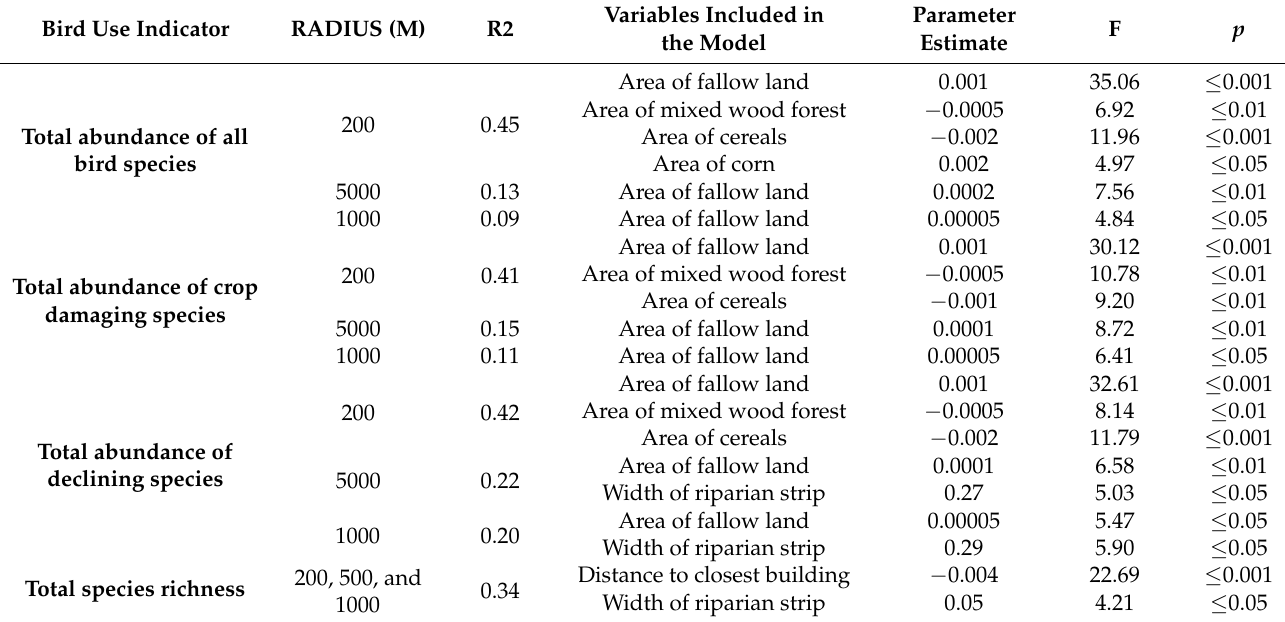
Table 4. Results of multiple regression analyses carried out to determine habitat and landscape variables influencing bird use of the 61 farm ponds studied in the Boyer River watershed, St. Lawrence Valley lowlands, Southern Quebec